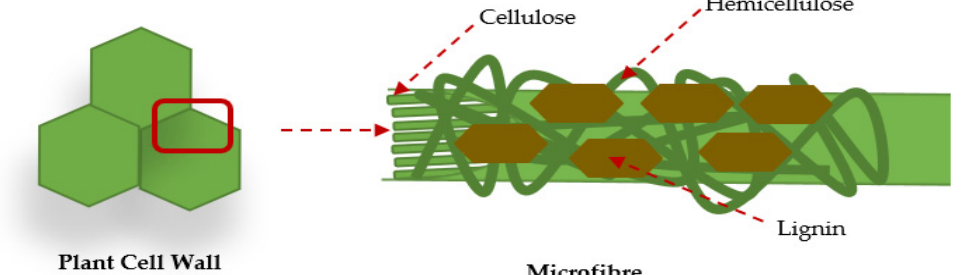
Figure 1. The main structure of lignocellulosic biomass.